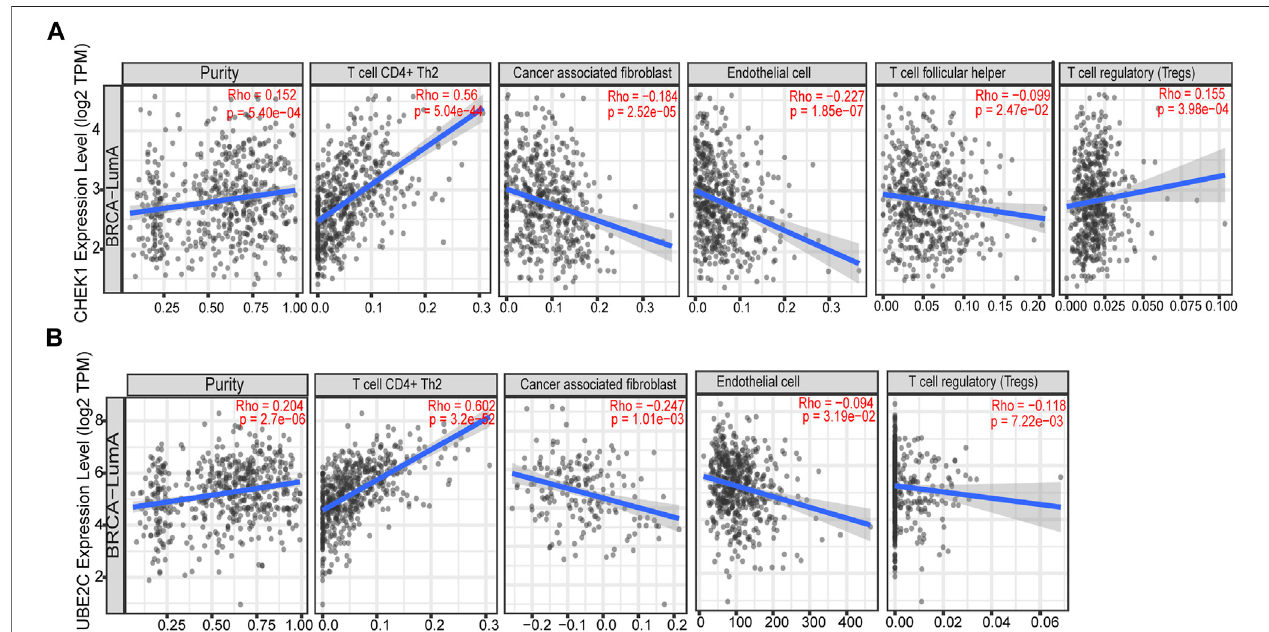
FIGURE6| Correlationoftheexpressionoftwohubgeneswithimmunein fi ltrationlevelinBRCAbasedonTIMER. (A) CorrelationoftheexpressionofCHEK1with immune in fi ltration level in luminal-A subtype of BRCA. (B) Correlation of the expression of UBE2C with immune in fi ltration level in luminal-A subtype of BRCA.